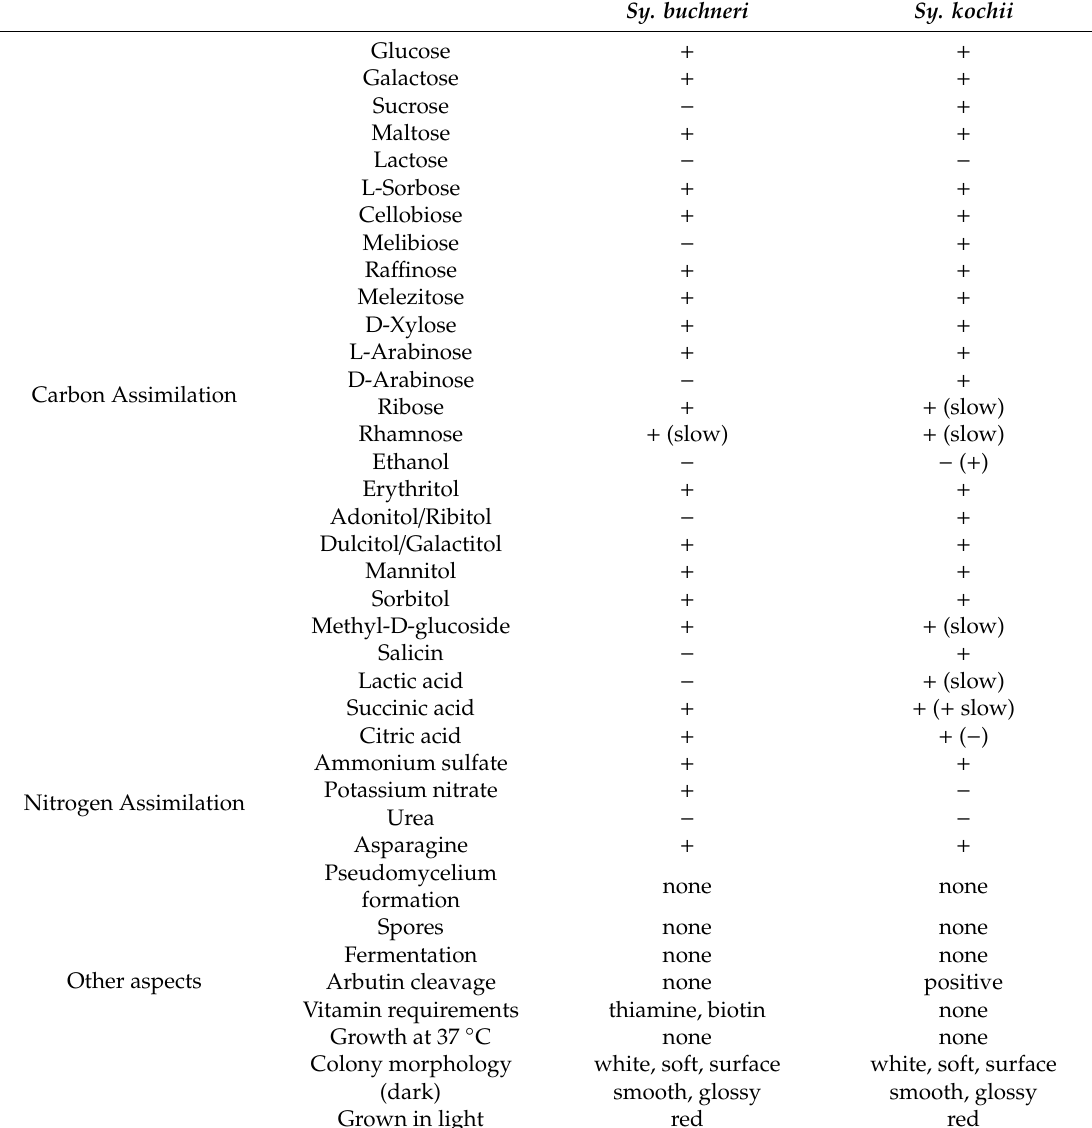
Table 2. Metabolism of Symbiotaphrina on culture